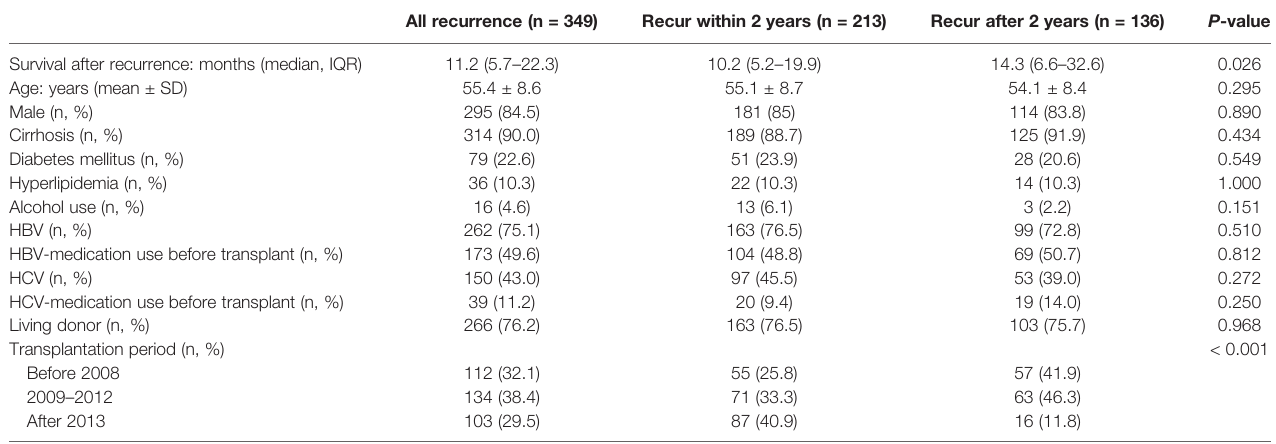
TABLE 1 | Patient demographics.